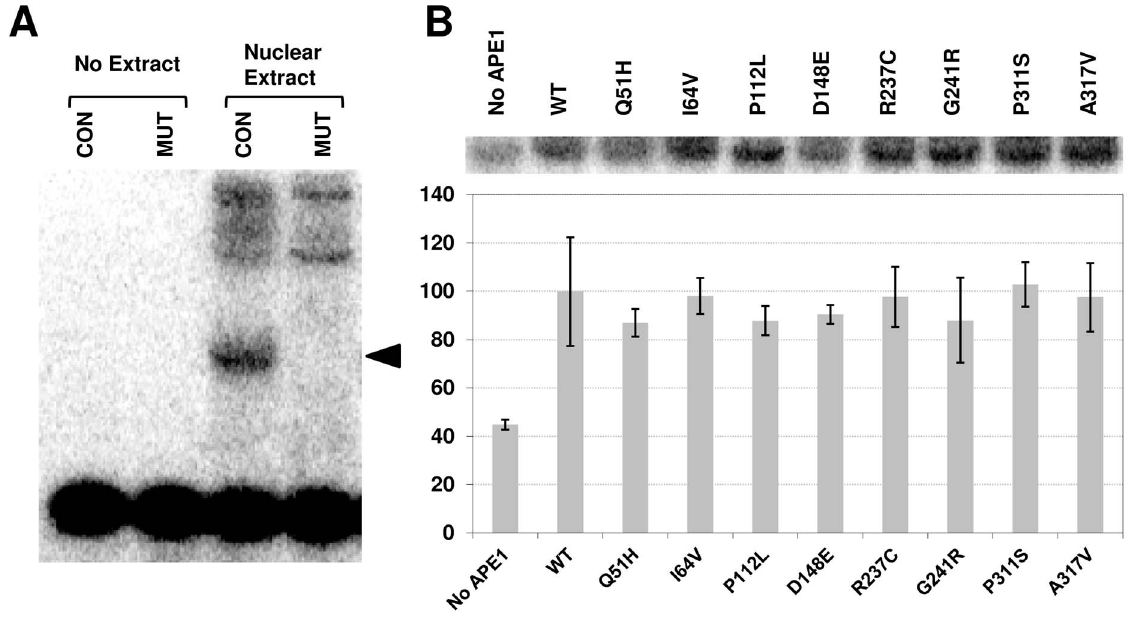
Figure 5. REF-1 assay. ( A ) HCT116 nuclear extract was incubated with 32 P-labeled consensus (CON) or mutant (MUT) AP-1 oligonucleotide substrates, and binding reactions were resolved on a non-denaturing polyacrylamide gel. Control reactions without nuclear extract (no extract) are shown. The arrow designates the position of the AP-1-specific consensus binding complex, not seen with the MUT double-stranded DNA. Higher molecular weight non-specific complexes are observed. ( B ) Reduced wild-type (WT) or variant APE1 protein was incubated with HCT116 nuclear extract in the presence of the 32 P-labeled AP-1 CON DNA substrate. Shown is the AP-1-specific complex in the absence (no protein) or presence of the indicated reduced APE1 protein after phosphorimager analysis. Plotted is the relative AP-1 DNA binding activity, in comparison with reduced WT protein. Values represent the average and standard deviation of 3 independent experimental points.